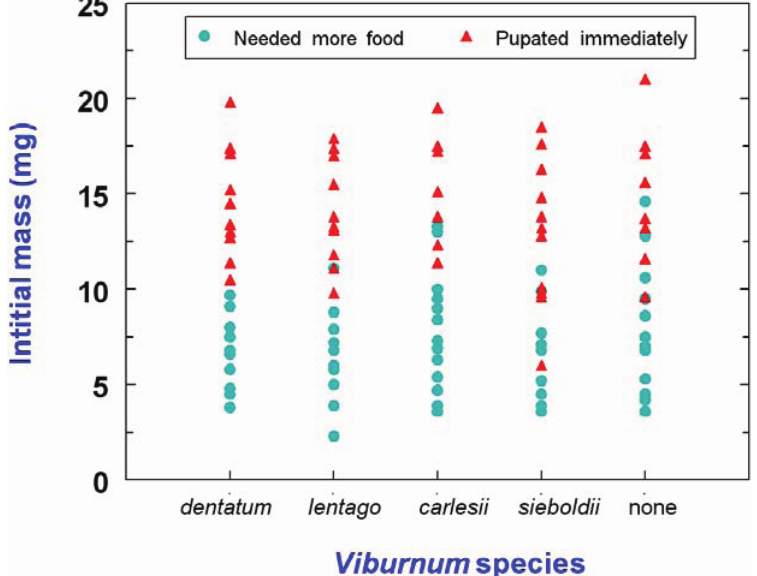
Figure A1. Distribution of the initial weight of individual P. viburni 3rd instar larvae used during the performance experiment. Color and shape of the dots indicate whether the larva pupated immediately by burrowing in the soil, or needed more food ( i.e. , started to feed on the host presented or starved to